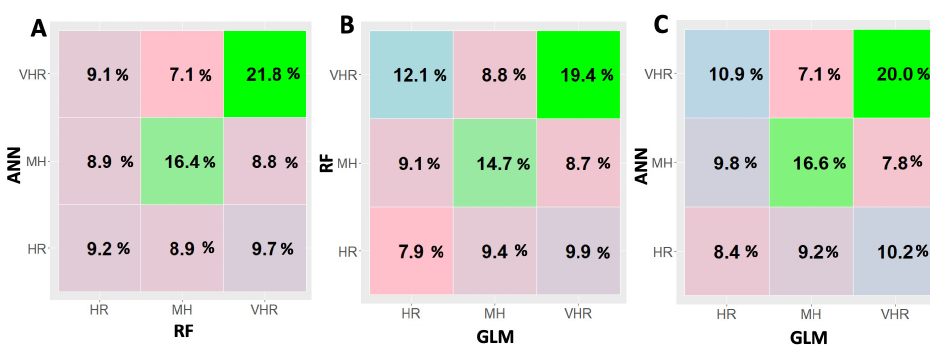
Figure 4. Contingency tables with pairwise comparisons of the implemented algorithms predictions: RF vs. ANN (panel A ), RF vs. GLM (panel B ), ANN vs. GLM (panel C ). The value are averaged over 100 rounds of 5-fold cross validation.